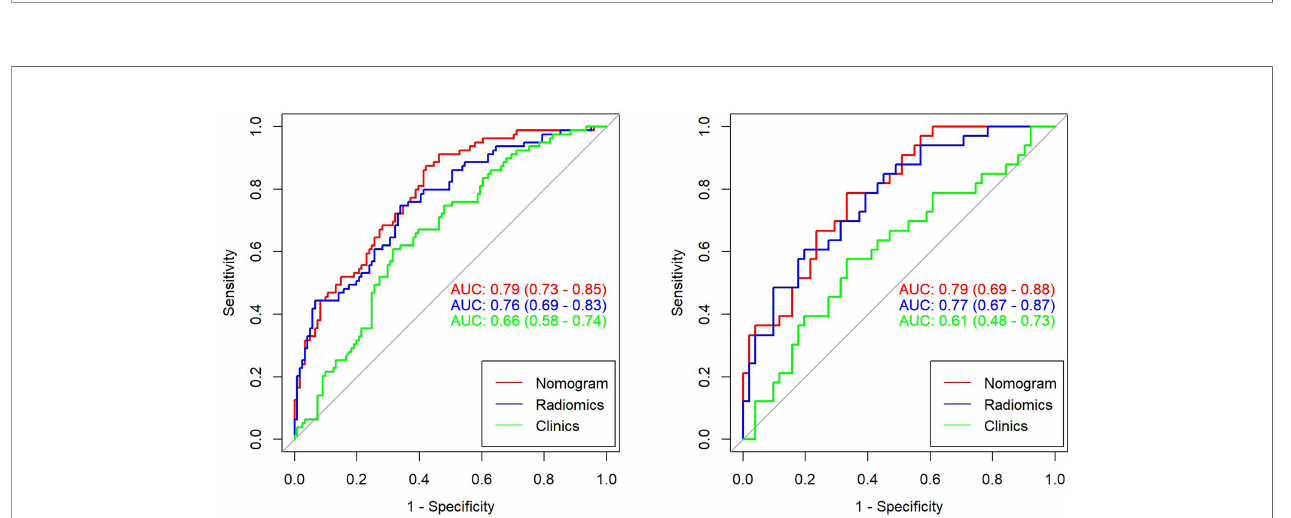
FIGURE 7 | Receiver operating characteristic (ROC) curves for the clinical model, radiomics model, and clinical radiomics nomogram of the training set and test set based on the T2-weighted imaging (T2WI) sequences. The left side shows the training set, whereas the right side shows the test set. The fi gure indicates that the radiomics and clinical radiomics models had greater area under the curve (AUC) values than the clinical model.